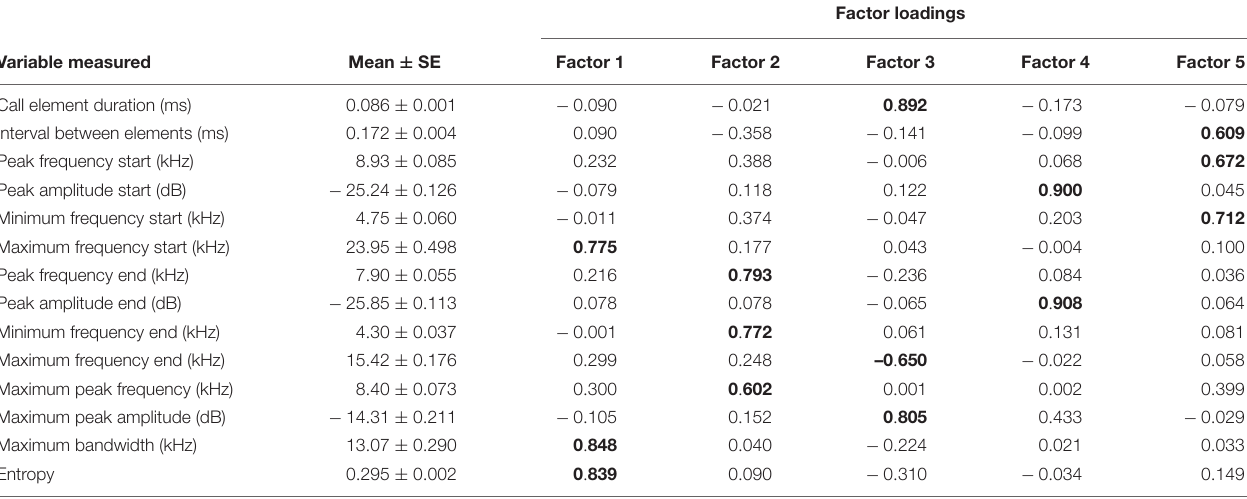
Factor loadings